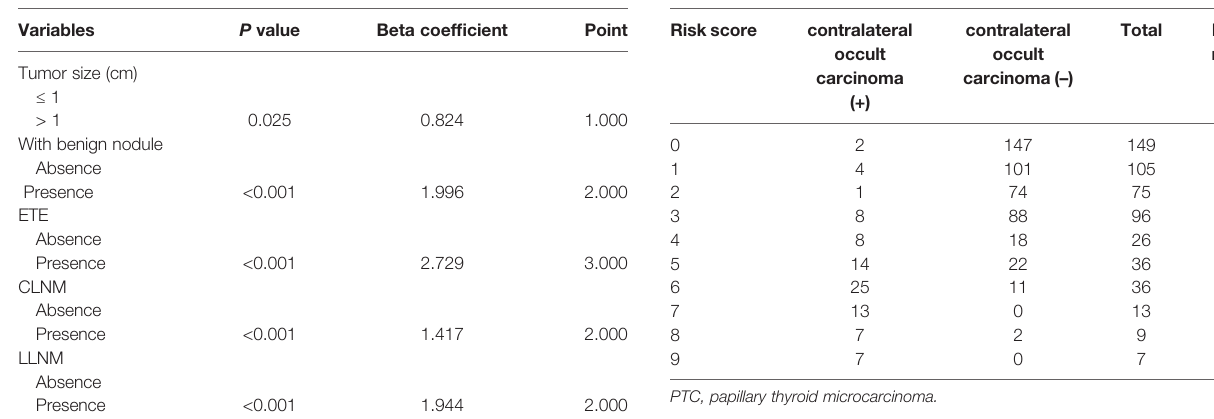
TABLE 5 | Development of a 10-point risk-scoring model to predict contralateral occult carcinoma in PTC patients.